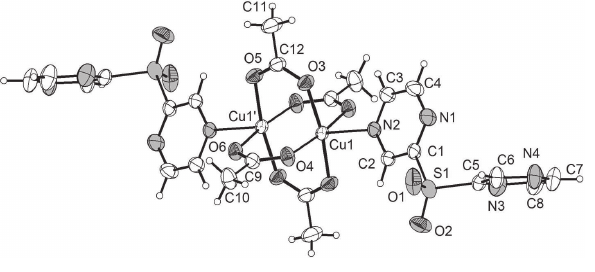
Table 1: Data collection and